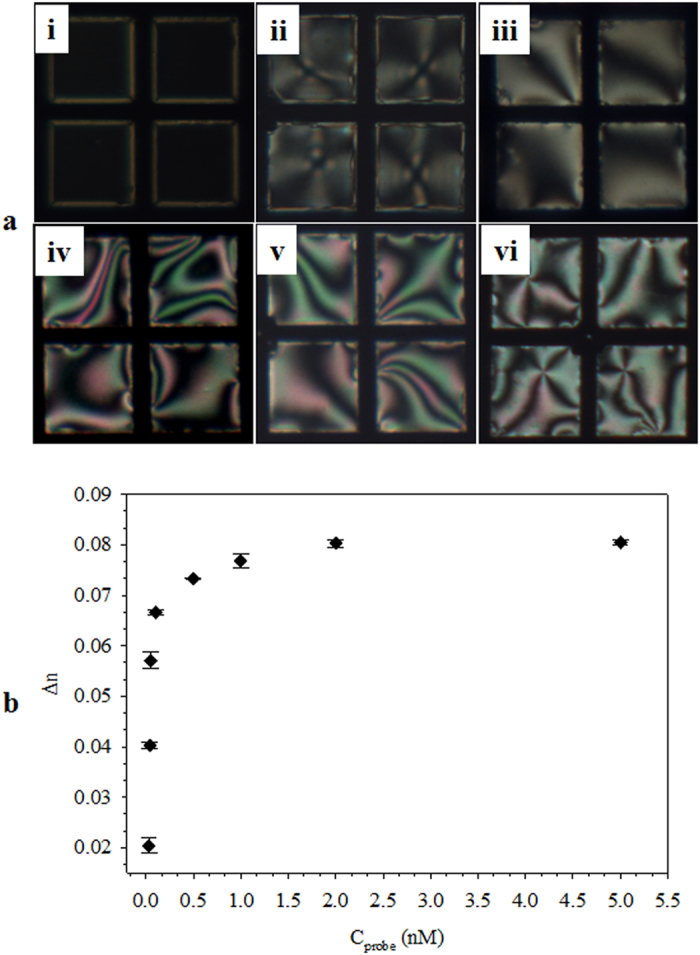
(a) Polarized optical microscopy images of TEMDTAB/DNAs at ssDNAprobe concentrations (Cprobe) of (i) 0.03, (ii) 0.050, (iii) 0.100, (iv) 0.500, (v) 1, and (vi) 2 μM. (b) The measured birefringence (Δn) of (a) as a function of Cprobe. The error bars represent standard deviation. TEMDTAB/DNAs, liquid-crystal-filled transmission electron microscopy grids coated with dodecyltrimethylammonium bromide (DTAB) and ssDNAprobe.